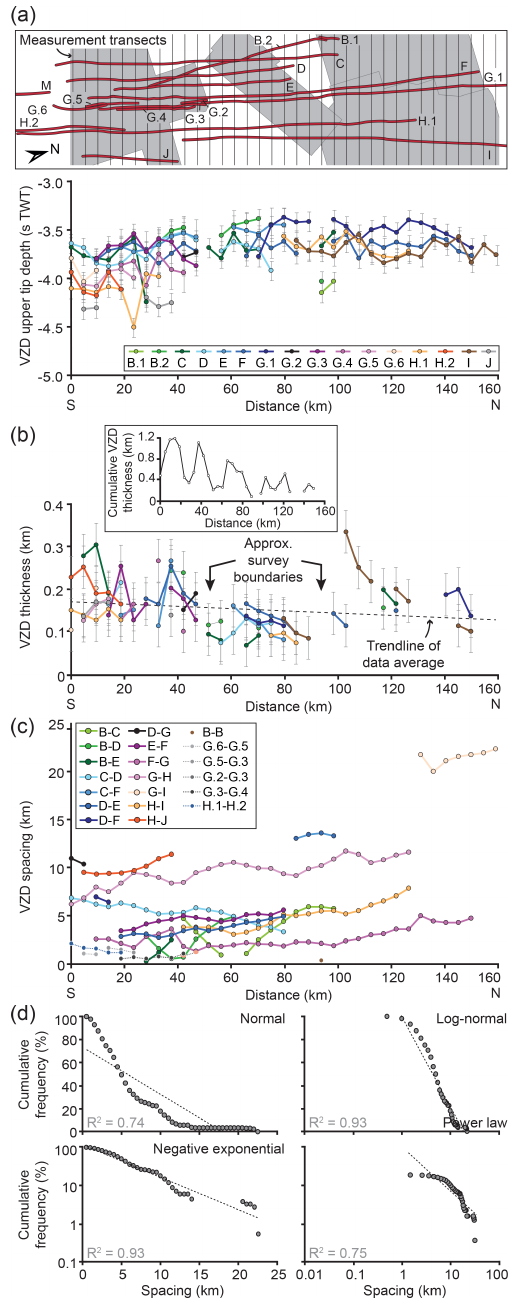
Figure 11. (a) Plot highlighting VZD upper tip depth, measured along transects shown in the inset map, which remains relatively consistent between 4 . 5 ± 0 . 45 to 3 . 4 ± 0 . 34s TWT from south to north. Error bars are ± 10%. (b) Plot depicting how VZD thickness changes from south to north. Error bars are ± 50m. Approximate (approx.) location of boundaries between the 3D seismic surveys are shown. Inset: plot of cumulative VZD thickness across each transect. (c) Plot depicting how VZD spacing changes from south to north. Error bars are smaller than data symbols. (d) Cumula- tive frequency plots showing VZD spacing is best described by a negative-exponential